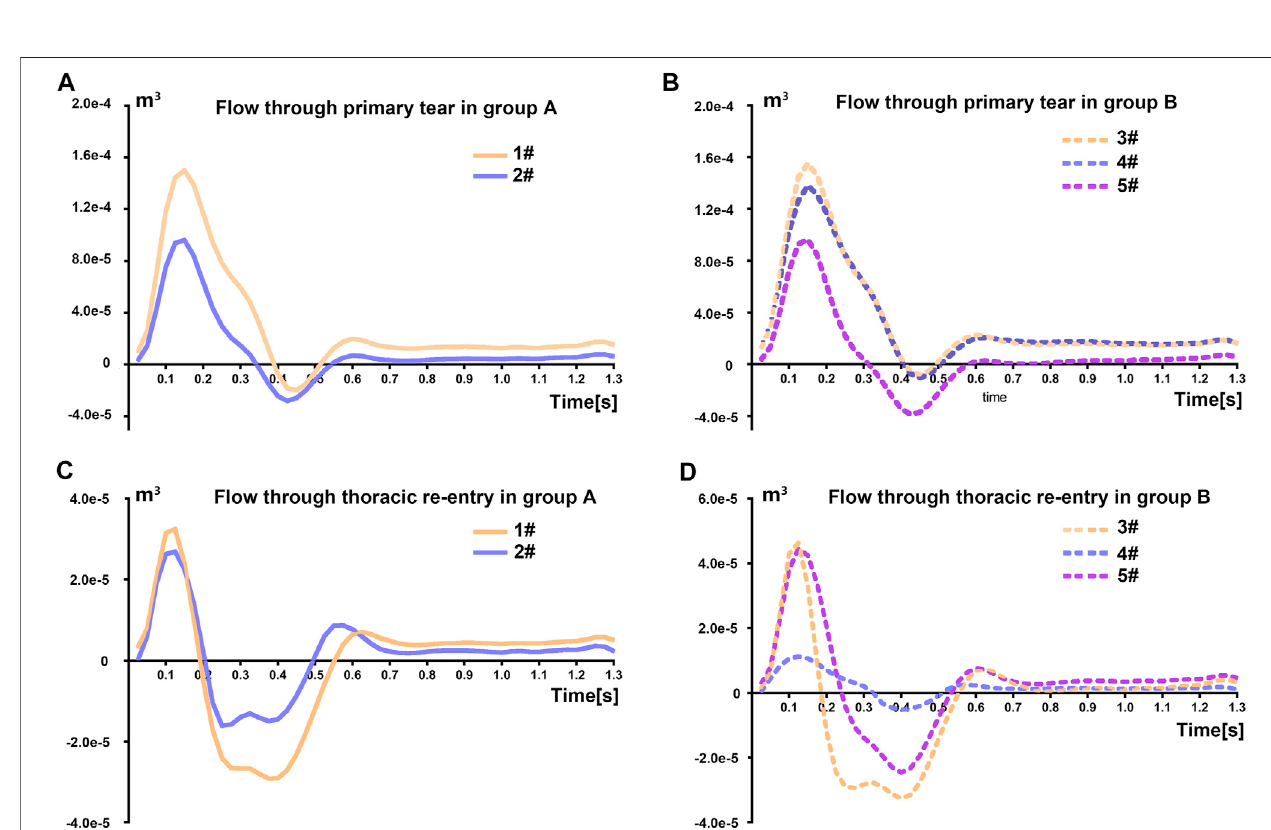
FIGURE4|(A – B) Time-variant fl owvolumeenteringthefalselumenviatheprimarytearofthepatients. (C – D) Thetime-variant fl owvolumeenteringthefalselumen via the thoracic re-entry tear of the patients.